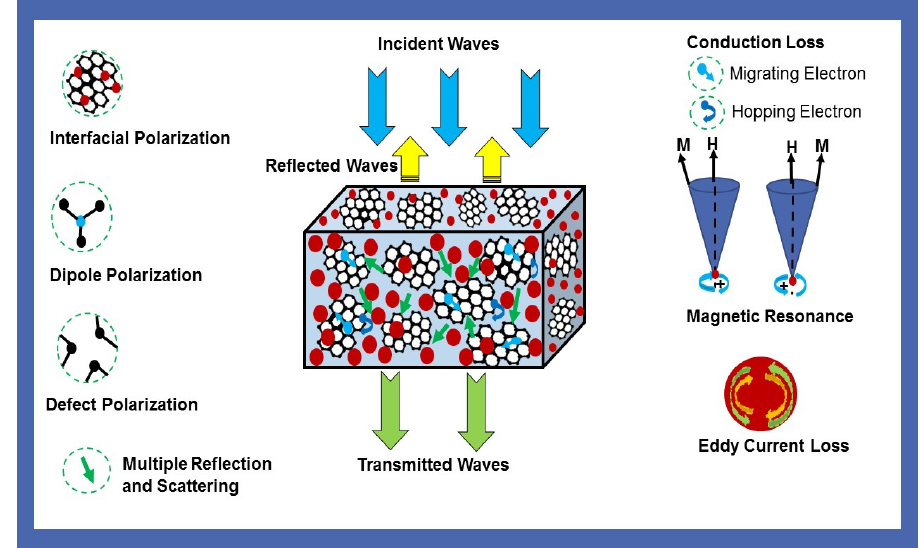
Figure 16. Schematic illustration of the electromagnetic interference shielding mechanism in prepared